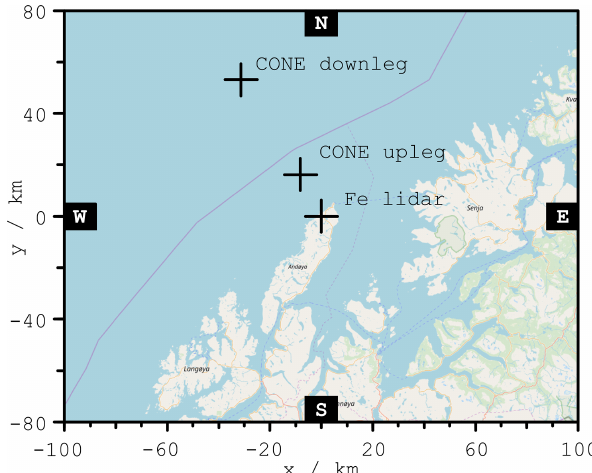
Figure 1. Map showing the area covered by the AMTM at the cen- troid altitude of the OH layer at about 86km. The points of mea- surement at that altitude are marked for each instrument (see text for further